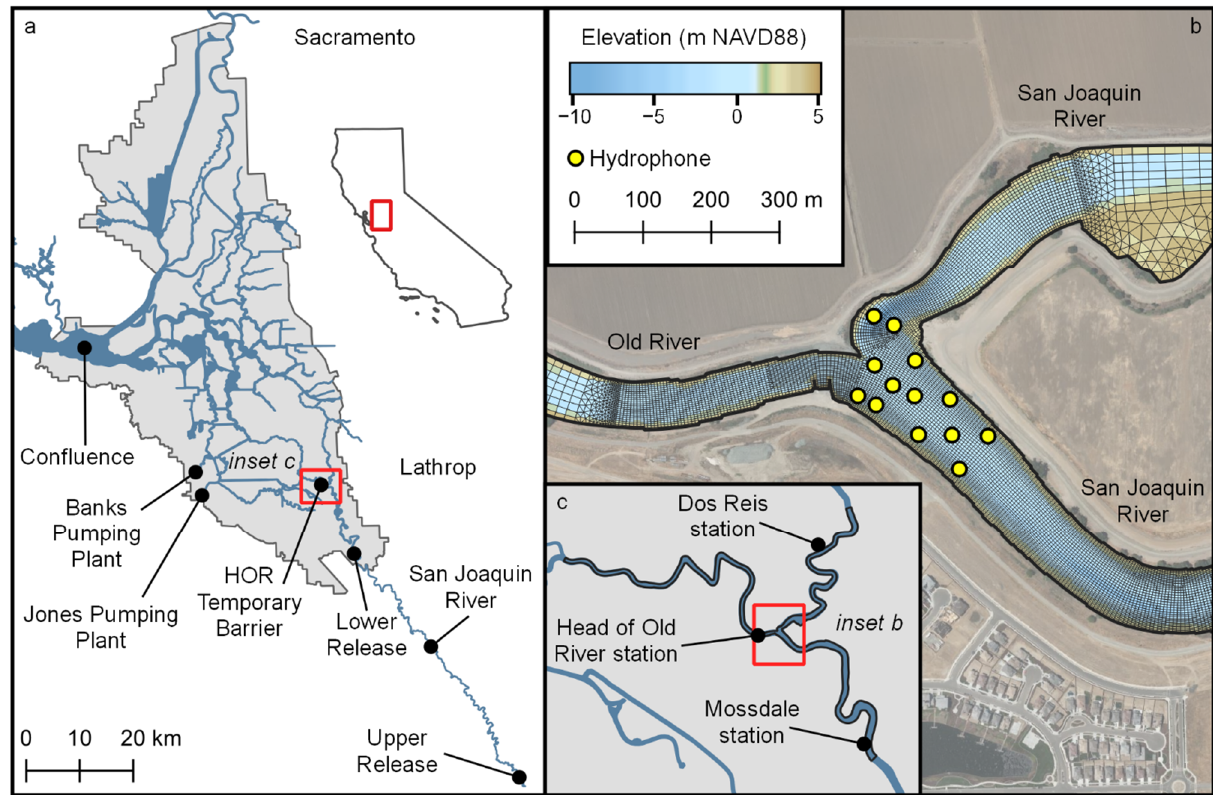
Figure 1. ( a ) Locations of interest including smolt release locations, with the extent of the Sacramento-San Joaquin Delta in grey shading; ( b ) computational grid, bathymetry and hydrophone location near the junction of the San Joaquin River and Old River; ( c ) the extent of the hydrodynamic model domain in black outline and the locations of flow observation stations.